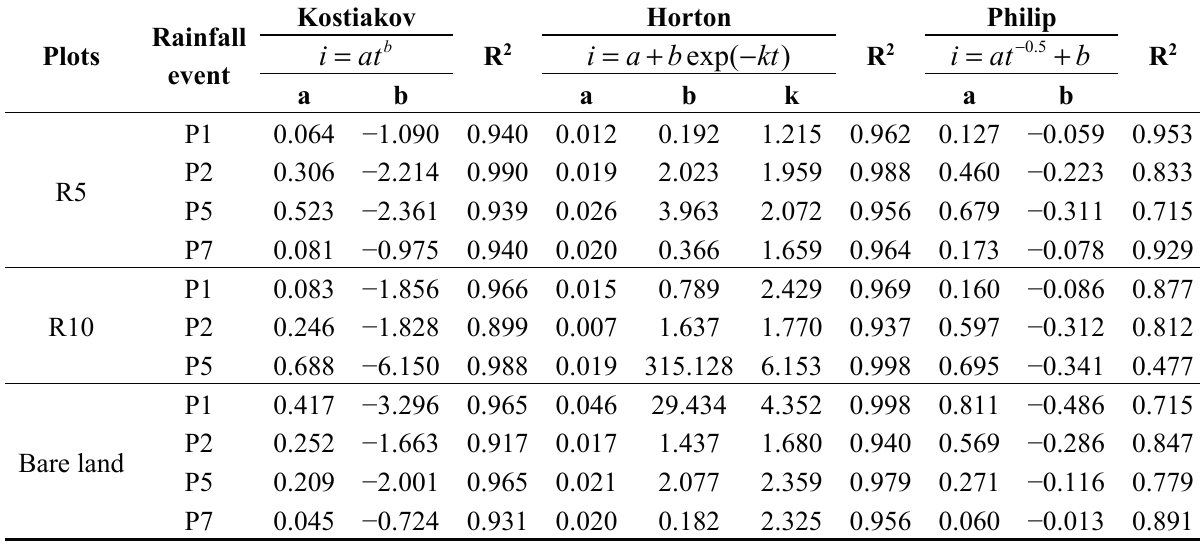
Table 5. Statistics of regression analysis and infiltration parameters of three classical infiltration models for bare land and both grassland plots